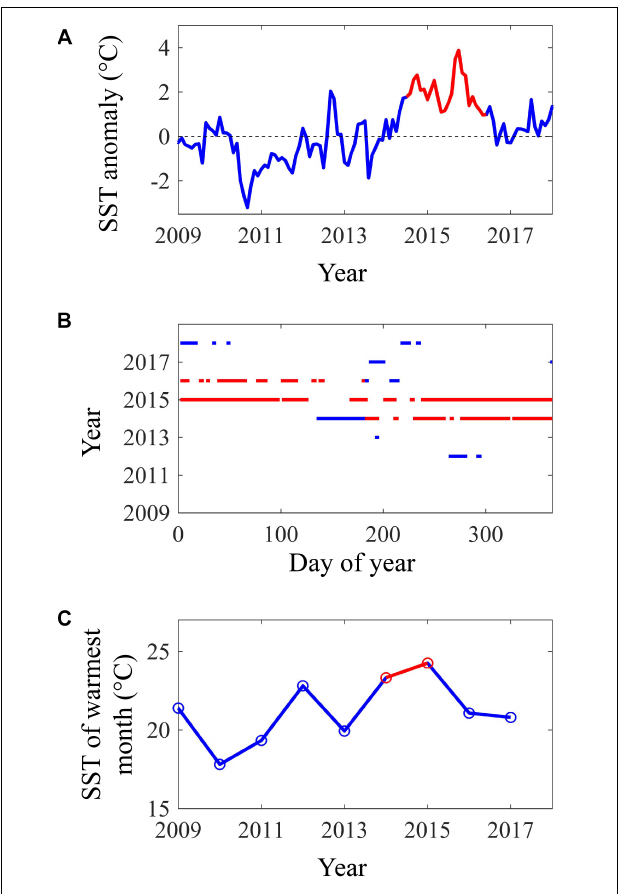
FIGURE 1 | SST metrics from 2009 to 2018 averaged across the thirteen 100 km coastline segments that comprised the study area (27.1 ◦ N to 34.5 ◦ N): (A) monthly anomalies in SST, (B) occurrence and duration of heat waves, and (C) SST of the warmest month of each year. The 2014–2016 warm anomaly is shown in